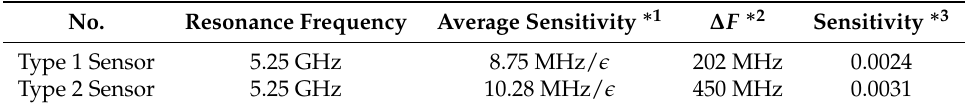
∗ 1 represents the average sensitivity obtained through relation of ∆ F shift among all the chemicals. ∗ 3 is the sensitivity obtained through